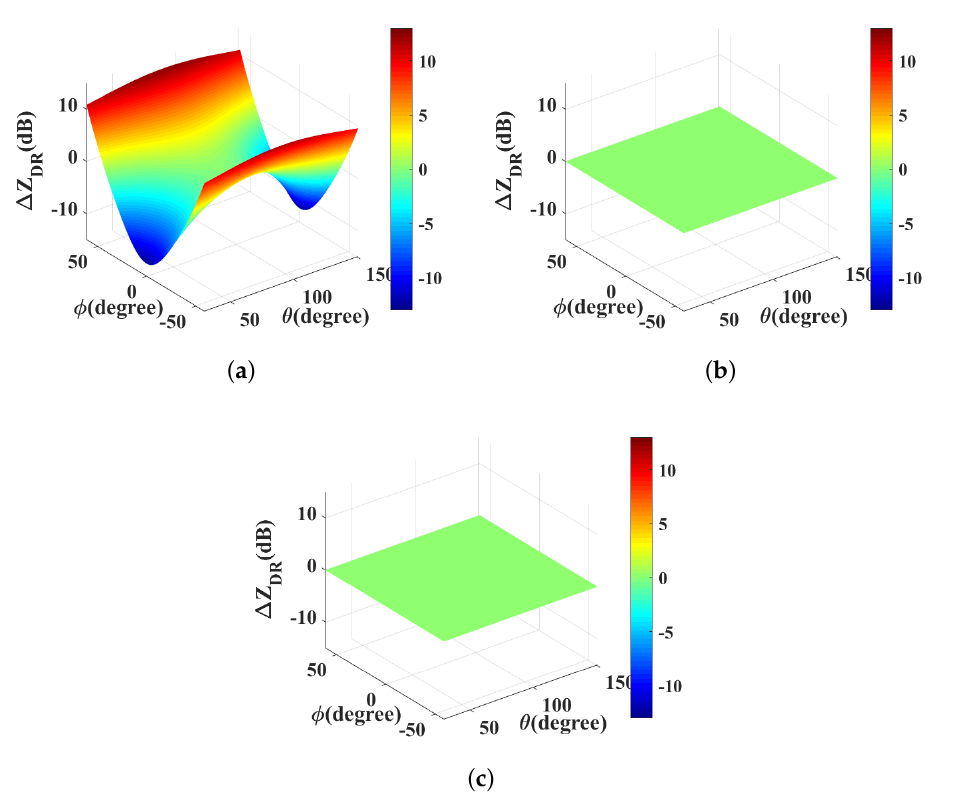
Figure 7. The bias of the linear depolarization ratio versus beam scanning angle. ( a ) LP wave; ( b ) CP wave; ( c ) EP